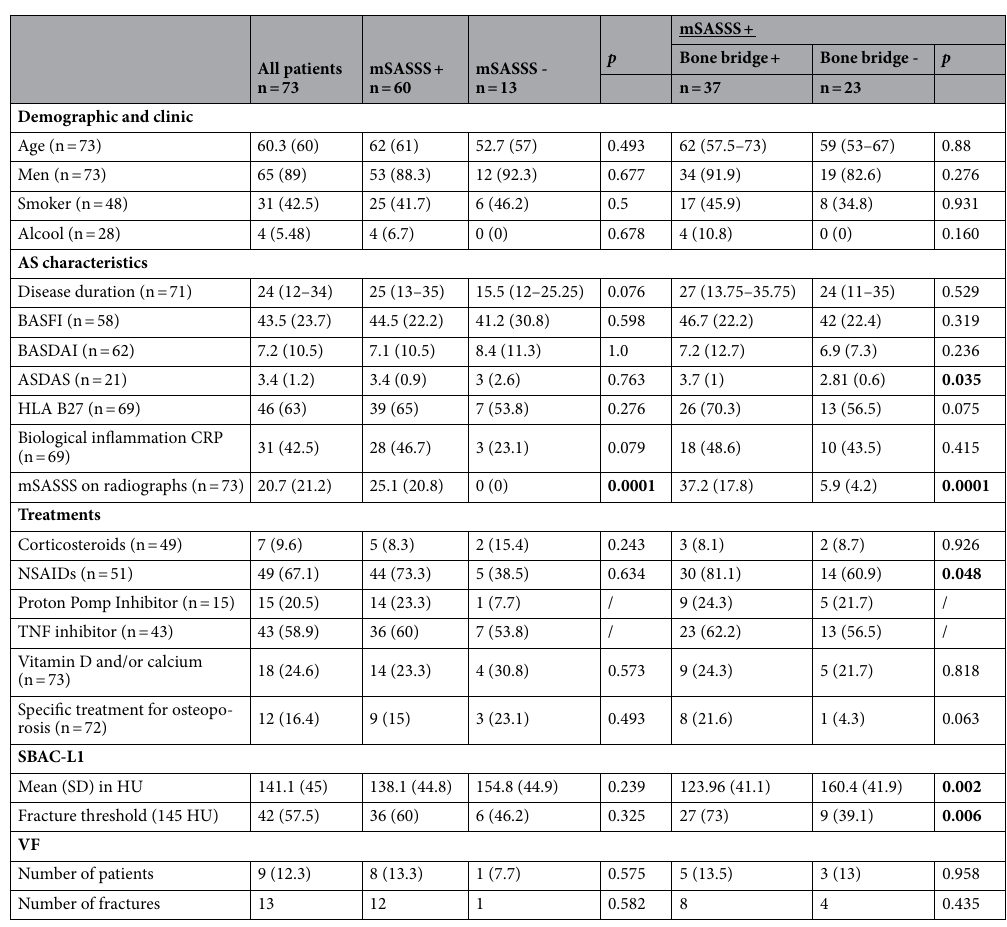
Table 1. Demographical, clinical characteristics and bone assessment on CT of the 73 AS patients according to spine structural involvement (mSASSS or vertebra ankylosis). all data in bold are statiscally significant data (p<0.05) AS, ankylosing spondylitis; ASDAS, Ankylosing Spondylitis Disease Activity Score; BASDAI, Bath ankylosing spondylitis disease activity index; BASFI, Bath ankylosing spondylitis functional index; CRP, C-reactive protein; HU, Hounsfield unit; mSASSS, modified Stoke Ankylosing Spondylitis Spinal Score; NSAIDs, Non-steroidal anti-inflammatory drugs; SBAC-L1, scanographic bone attenuation coefficient of the first lumbar vertebra; SD, standard deviation; TNF, tumour necrosis factor; VF, vertebral fracture. Age in mSASSS + group and disease duration are in median (IQR), whereas age in general population, BASDAI, BASFI, ASDAS are in mean (± SD). In the comparisons, the Student’s t-test or the Mann–Whitney U test were used. For qualitative variables, the chi-square test with, if necessary, the exact calculation of Fisher was used. The risk α was established as 0.05. mSASSS + was defined by a mSASSS ≥ 2, with the presence of at least one